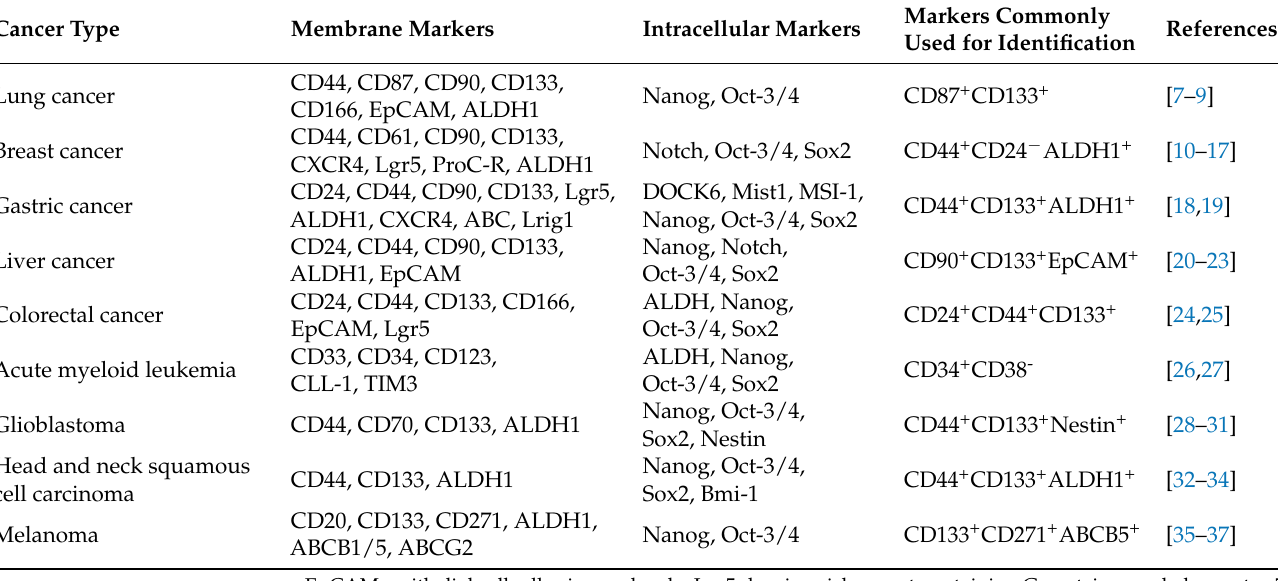
Table 1. Common CSC markers for various types of